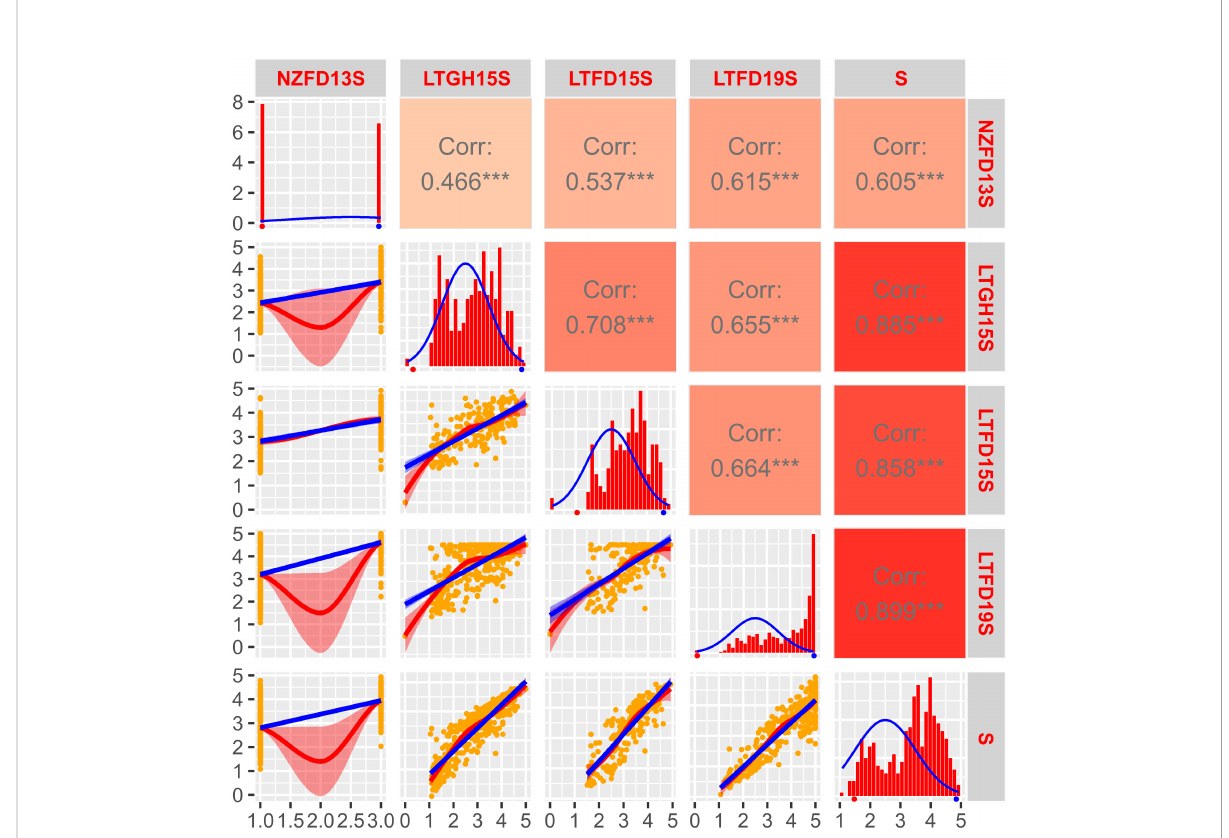
FIGURE 3 Frequency distribution and correlation scatterplots for solid stem rating of doubled haploid population ‘ AAC Innova/P2711 ’ . Frequency distribution histograms with distribution curve (blue line) for solid stem score of DHs grown in New Zealand fi eld trial in 2013 (NZFD13S), at Lethbridge, Alberta in the greenhouse in 2015 (LTGH15S), the fi eld in 2015 (LTFD15S) and 2019 (LTFD19S), as well as pooled data (average of all three environments; S) are shown on main diagonal. The means of the parental genotypes ‘ AAC Innova ’ (hollow-stemmed) and P2711 (solid- stemmed) are indicated by red and blue dots, respectively, beneath the frequency distribution plots. Scatterplots with regression lines, linear (blue) and exponential (red), for each environment are shown on the left side of the main diagonal. Orange dots on scatterplots represent the solid stem score of DHs. Correlation coef fi cients ( r ) between each pair of environments, and each environment and the pooled data, are displayed on the right side of the main diagonal. Color intensity (light red to dark red) on r boxes indicates the depth of association between environments under evaluation. ***p ≤